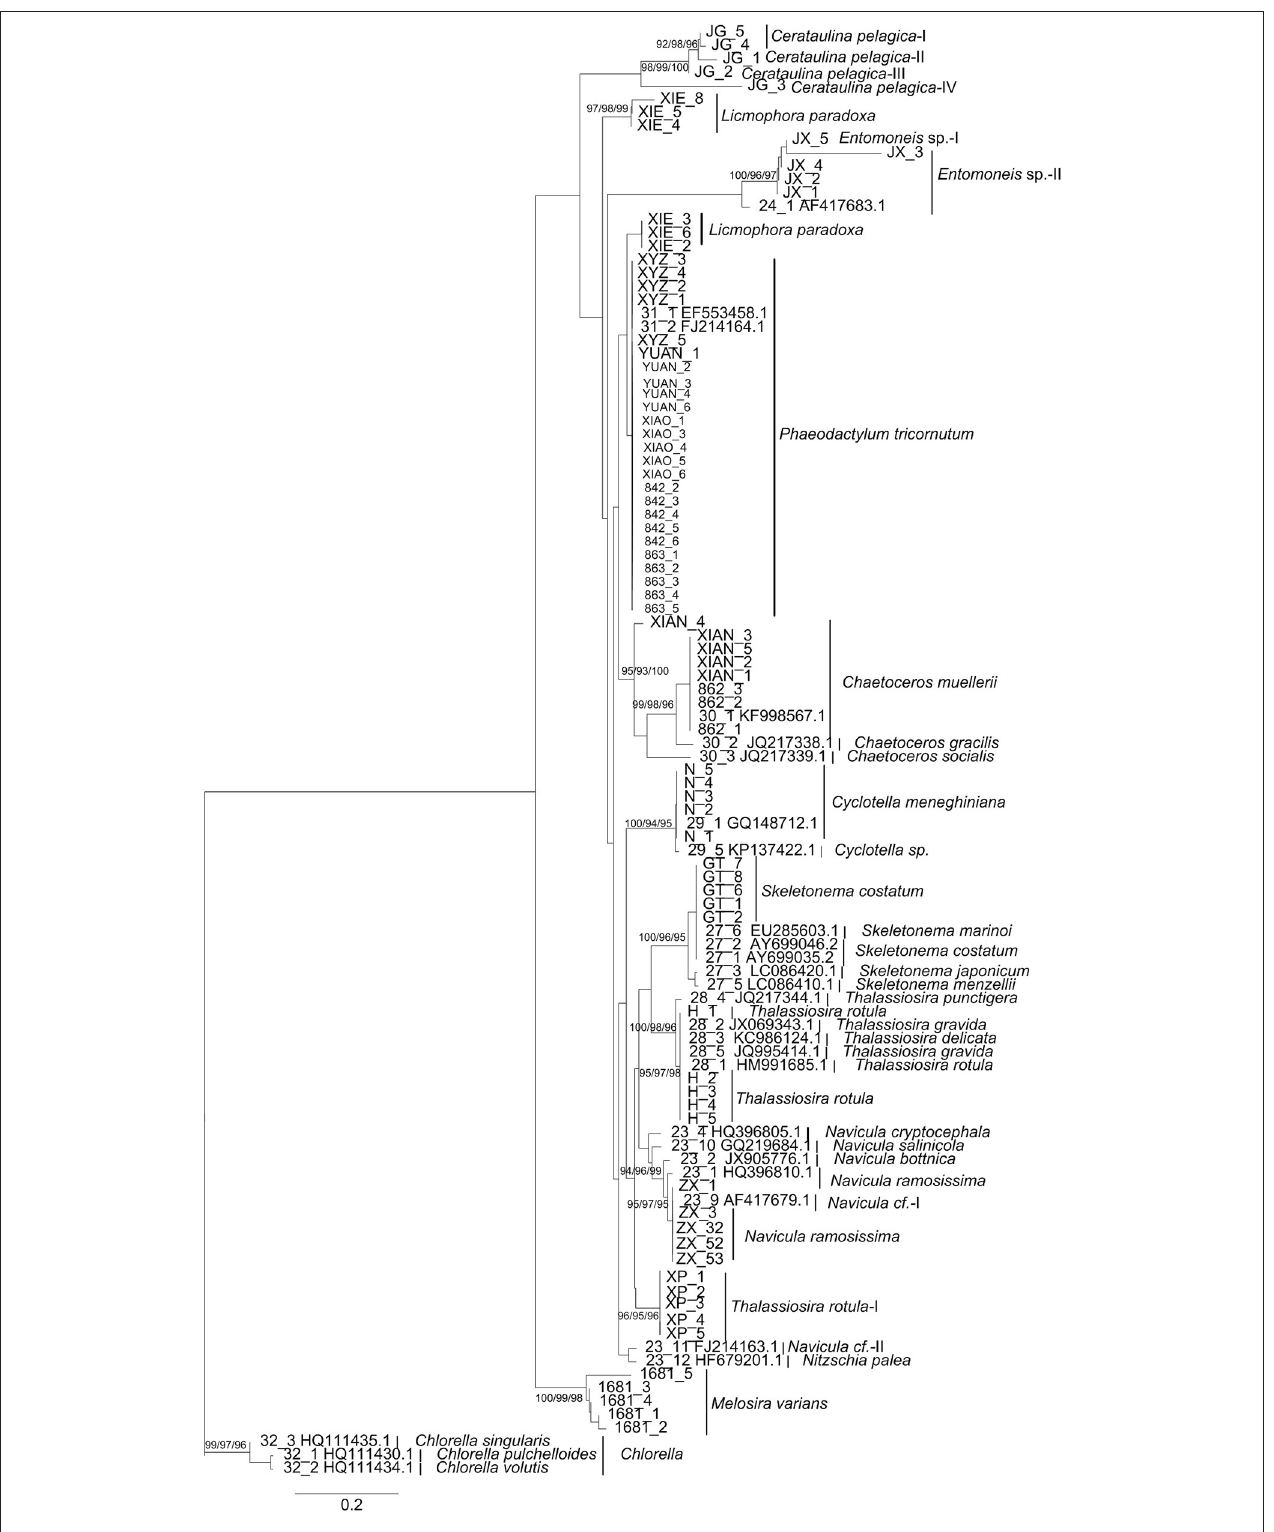
FIGURE 4 | Bayesian phylogenetic tree for combined gene sequences of the four gene loci. The NJ, Bayesian, and Maximum Likelihood bootstraps are indicated for species.